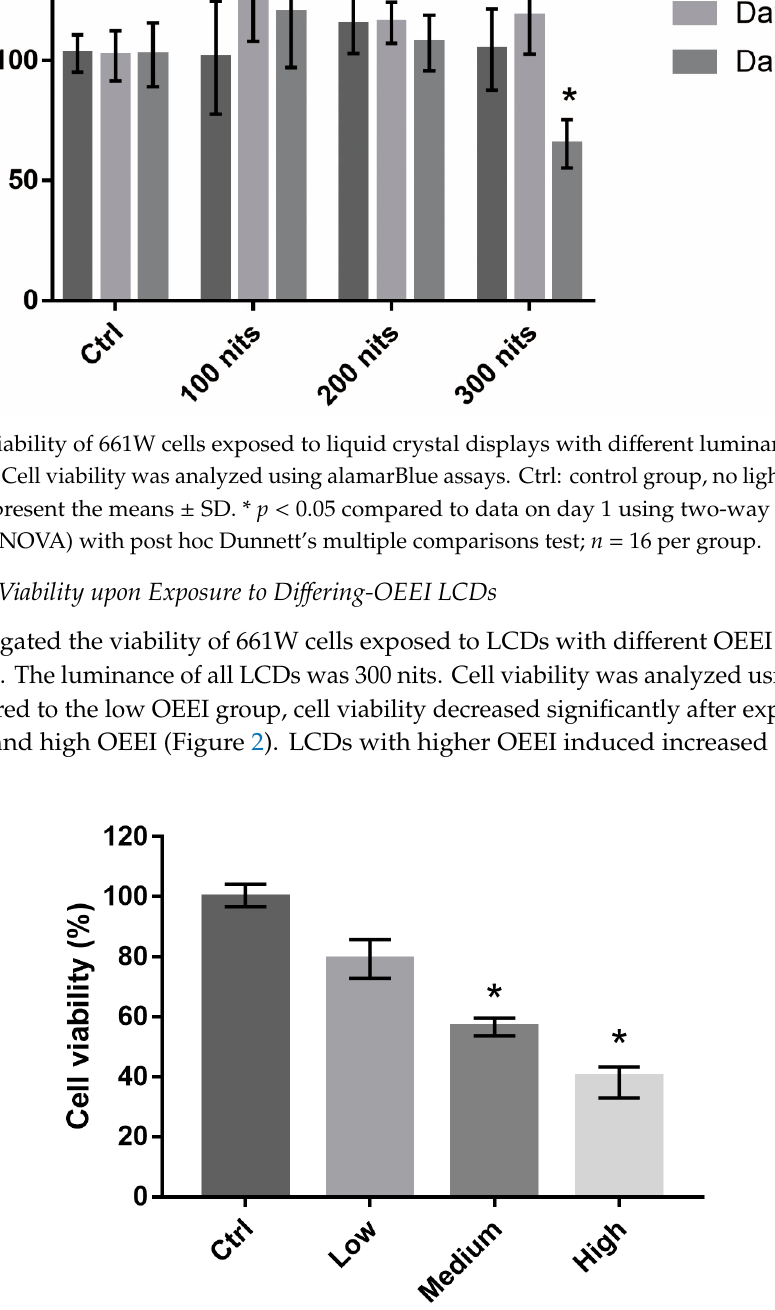
Figure 2. Viability of 661W cells exposed to liquid crystal displays with different ocular energy exposure index (OEEI) values for 3 days. Cell viability was analyzed using alamarBlue assays. Ctrl: control group, no light exposure; All data represent the median and the interquartile range. *p < 0.05 compared to the low OEEI group using the Kurskal-Wallis test with post hoc Dunn test; n = 12 per group.